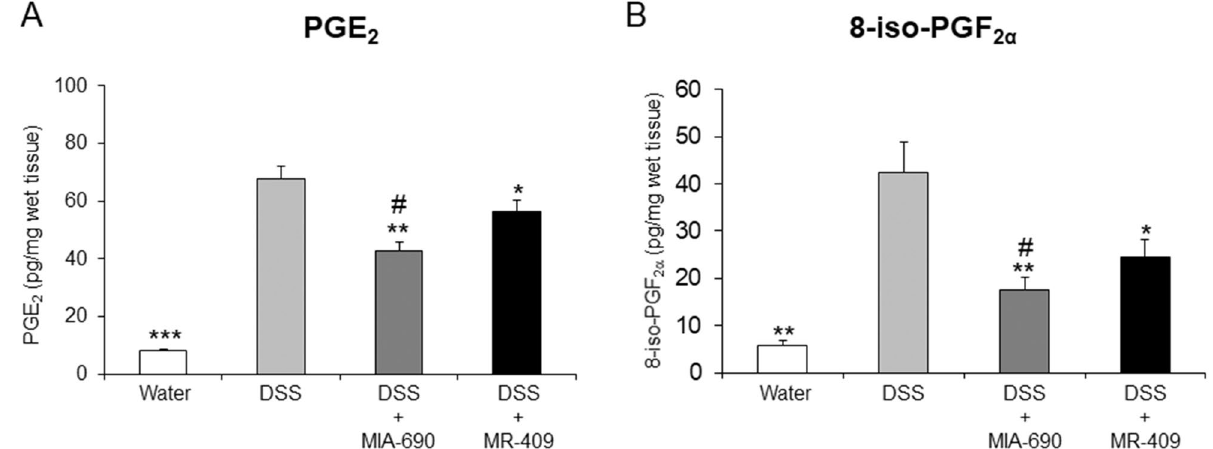
Figure 8. Inhibitory effects of MIA-690 (5 g) and MR-409 (5 μg) on prostaglandin E 2 ( A ) and 8-iso- prostaglandin F 2α ( B ) levels in colon segment of DSS-induced colitis (n = 6 for each group of treatment). Water group were control mice untreated with DSS. Data are expressed as means ± S.E.M. and analyzed by analysis of variance (ANOVA) followed by Bonferroni post-hoc test * p < 0.05 ** p < 0.01,*** p < 0.005 versus water controls; # p < 0.05 versus MR-409 treated